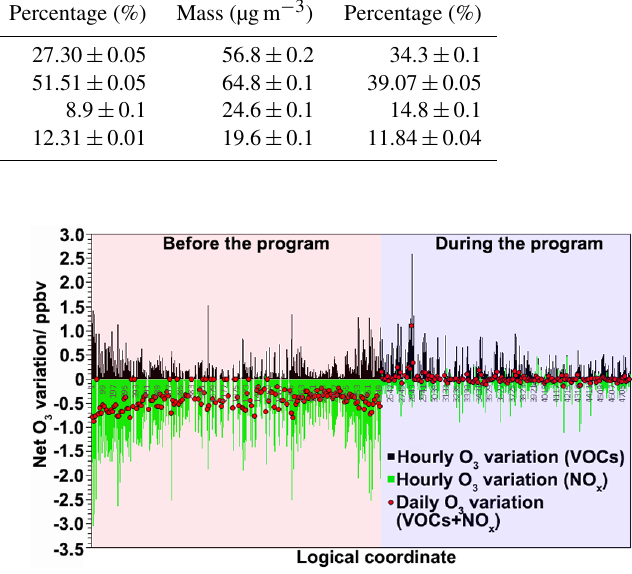
Table 6. Mass concentration and percentage contribution of the four sources to VOCs at MK before and during the program. Source Before